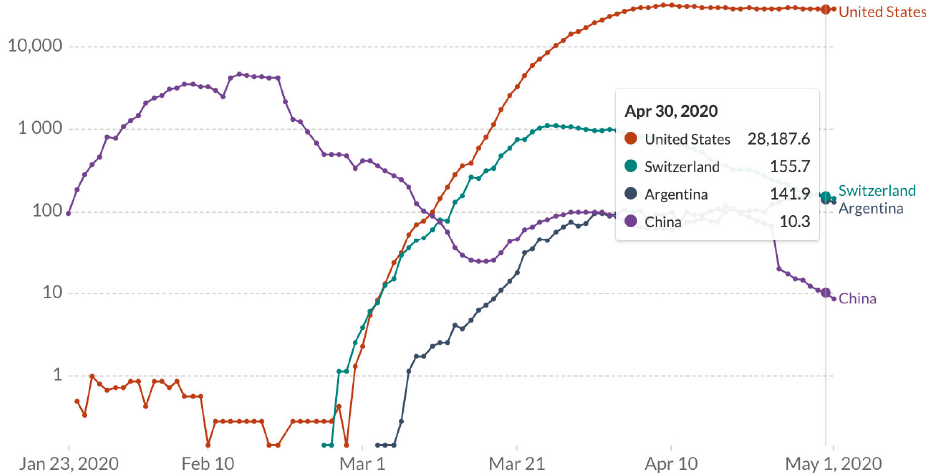
Figure 4. Scale of cumulative confirmed cases of COVID-19 in Argentina, Switzerland, China and the United States. Data retrieved from John Hopkins Coronavirus Resource Center. Last updated 1 May 2020.